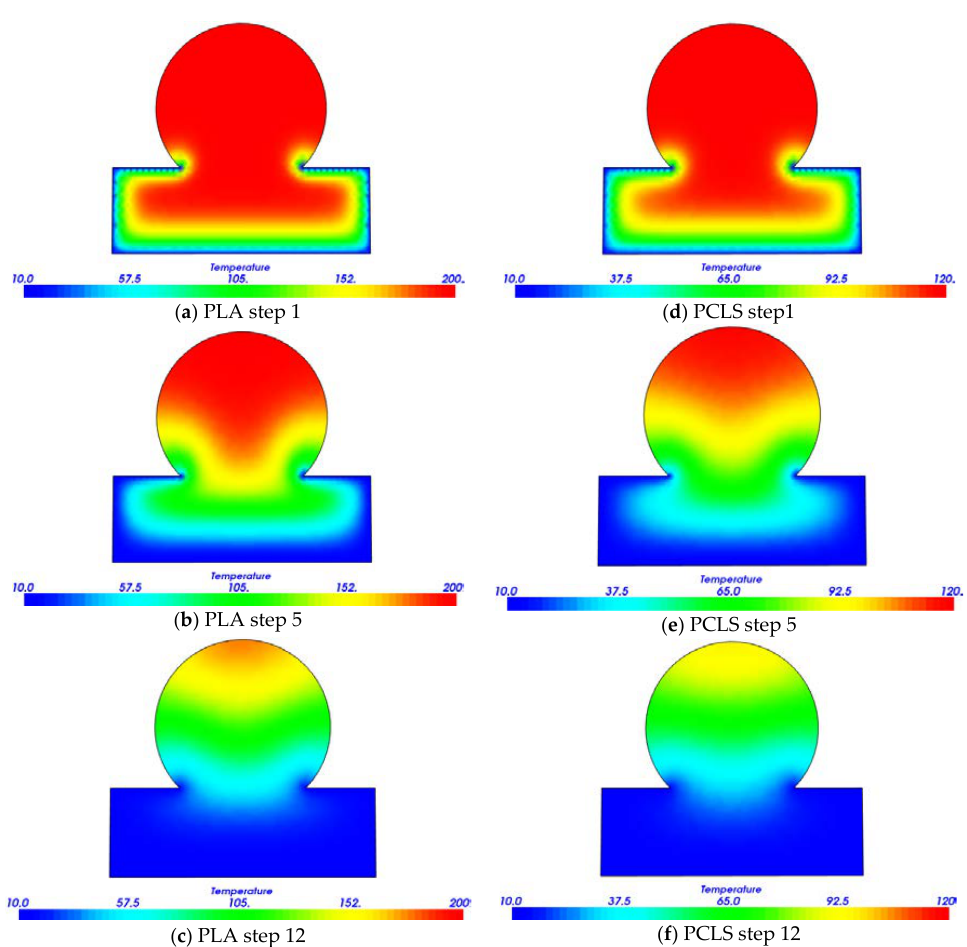
Figure 7. Thermal distribution during the self-adhesion process at different steps for: PLA ( a – c ); and PCLS; ( d – f ) (temperature units are in °C). The step size is equal to 0.05 s.